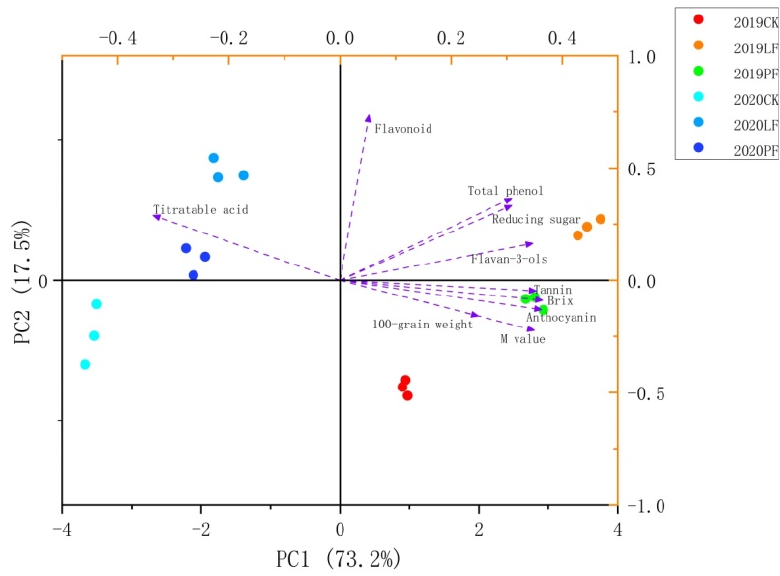
Figure 10. Principal component Analysis (PCA) of fruit quality index in 2019 and 2020.